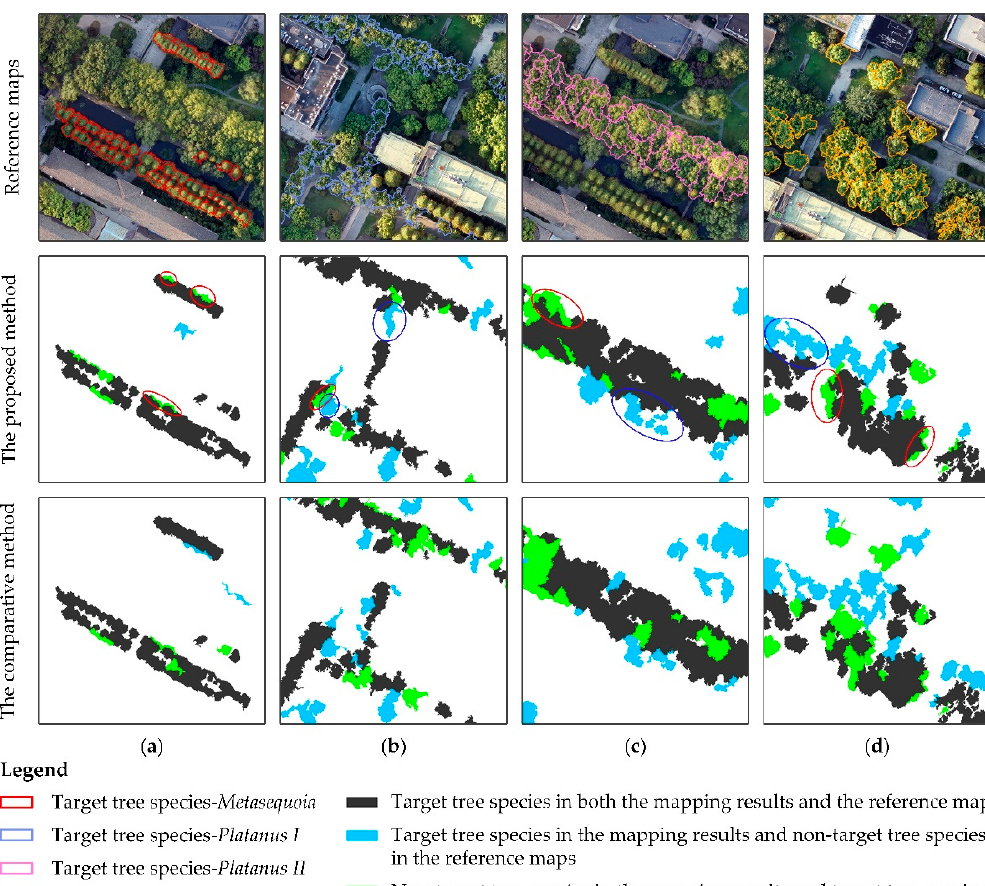
Figure 7. Portions of mapping results for four tree species using the proposed method (using VBSD for χ 2 distance) and the comparative method according to the reference maps labeling tree-crown objects for a specific tree species: Metasequoia ( a ); Platanus I ( b ); Platanus II ( c ); Camphora ( d ). Some under-estimated areas on the edges of trees are circled in red and some over-estimated areas around the target tree species are circled in blue.